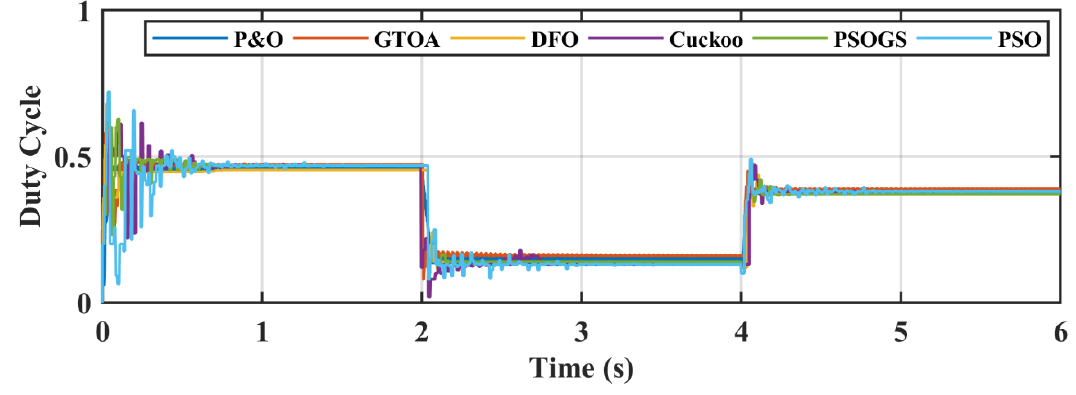
Figure 12. Zoomed-in comparison of duty cycle of GTOA. Figure 13. Comparison of voltage transients of GTOA.